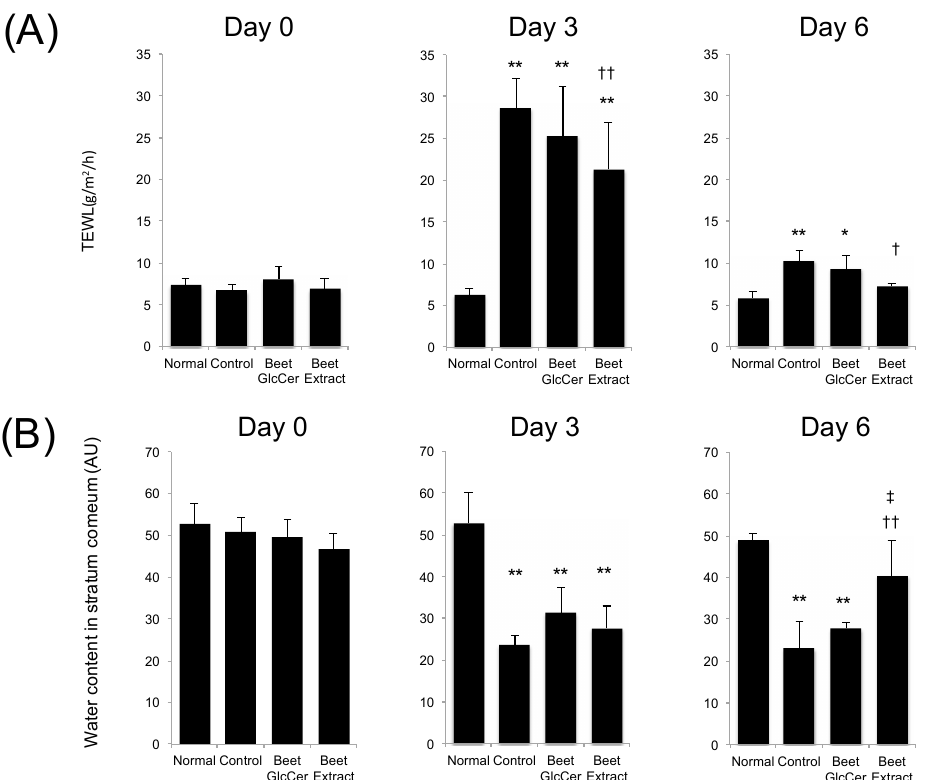
Figure 4. Effects of oral administration of beet GlcCer or beet extract on TEWL and stratum corneum after UVB irradiation. ( A ) Transepidermal water loss (TEWL); ( B ) water contents in stratum corneum. Values are shown as means ± standard deviation ( n = 6 at day 0 and 3, n = 3 at day 6). * p < 0.05, ** p < 0.01 vs. normal group, † p < 0.05 vs. control group, †† p < 0.01 vs. control group, ‡ p < 0.05 vs. beet GlcCer group, Tukey’s post-hoc multiple comparison test.